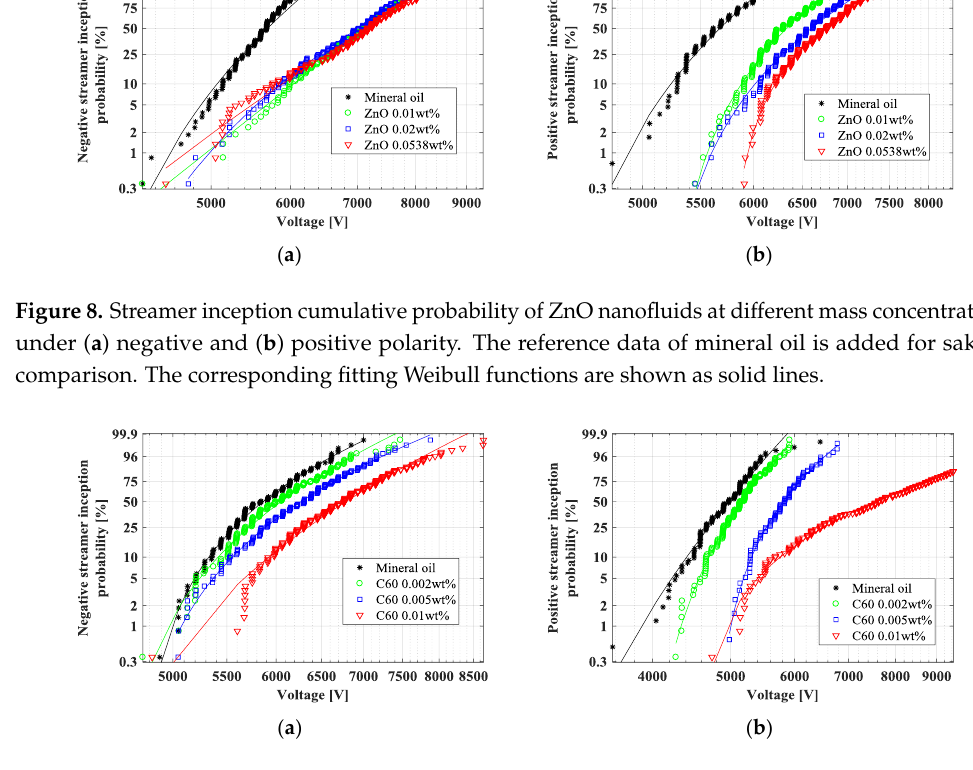
Figure 10. Change in 𝑉 50% of ZnO nanofluids relative to mineral oil as a function of mass fraction 𝑤 𝑖 .